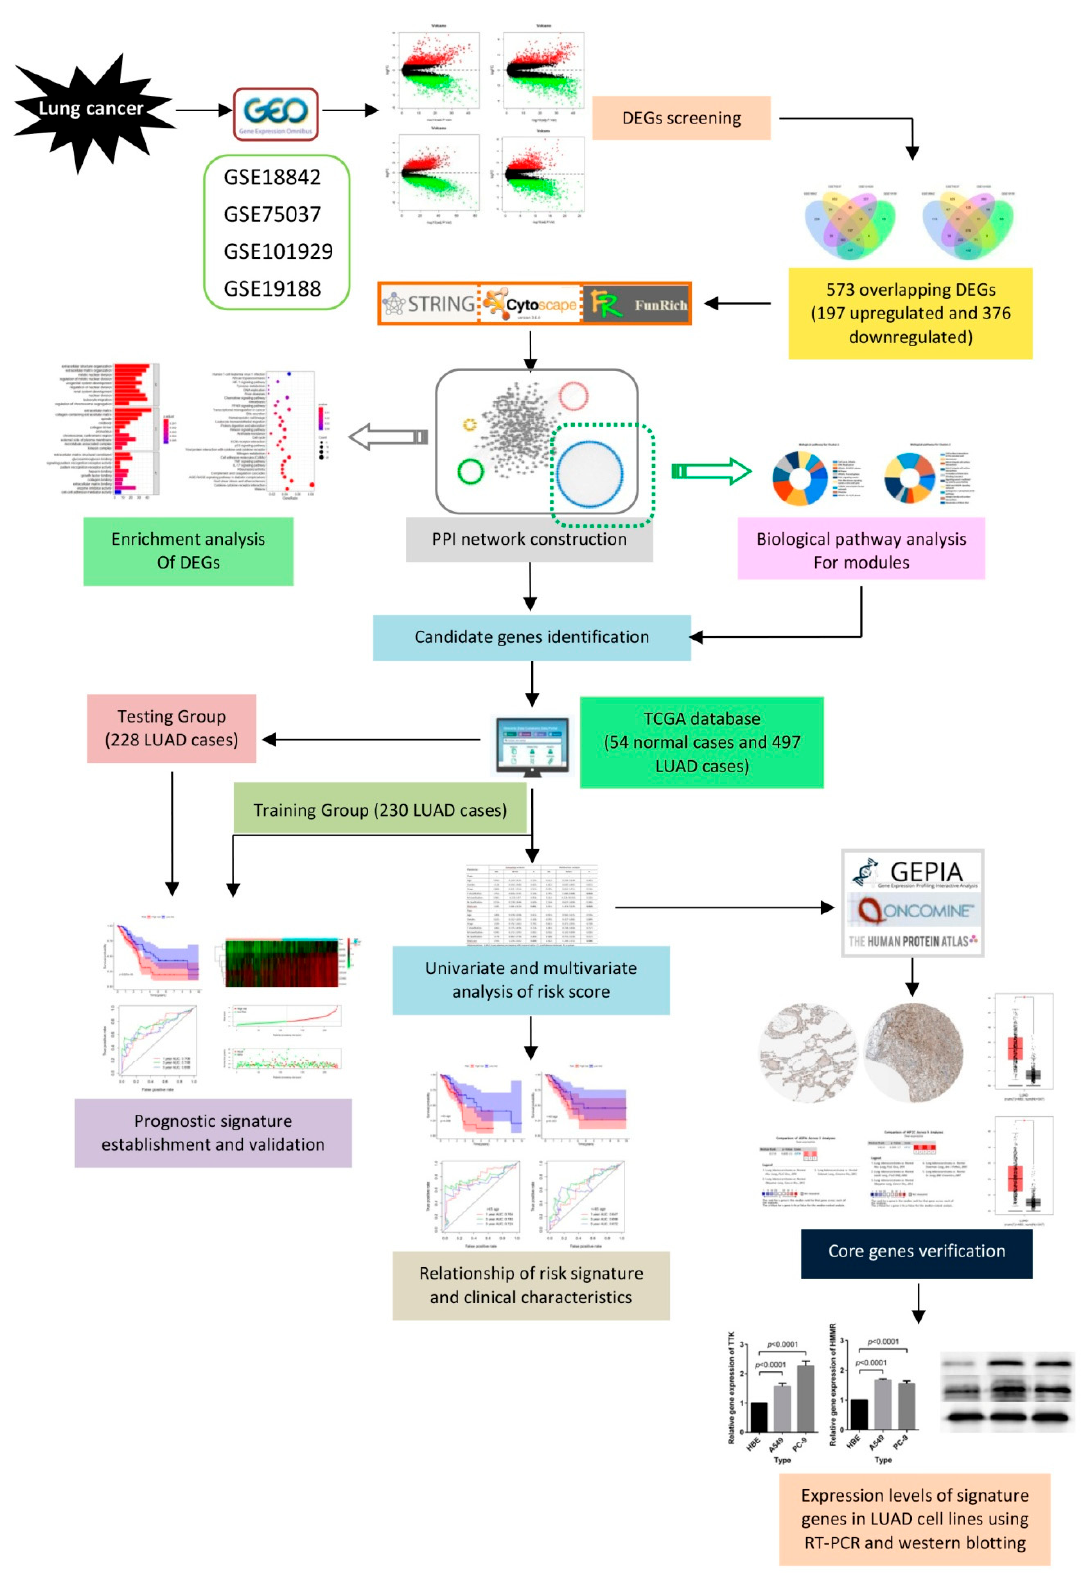
Figure 1. Flow chart for the construction of a risk score model in lung cancer.